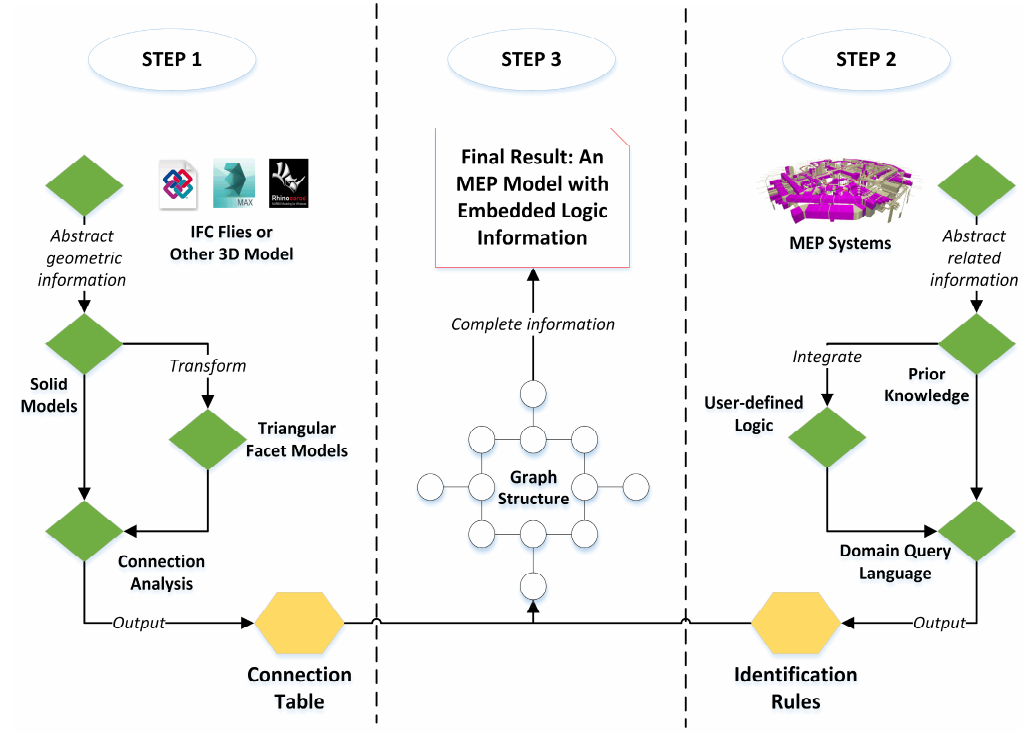
Figure 3. Flow diagram of the automatic completion mechanism.